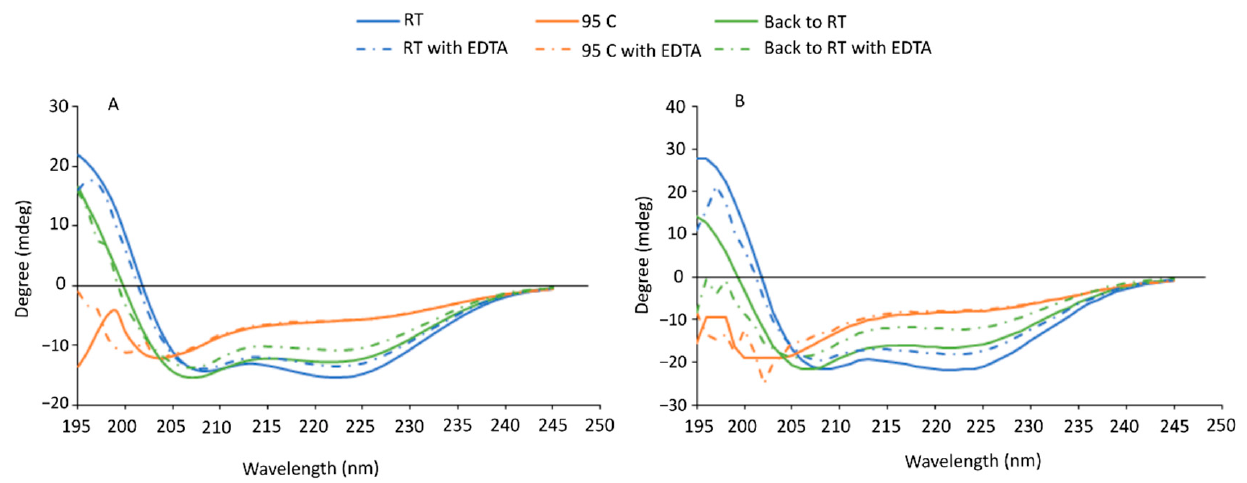
Figure 2. Far-UV circular dichroism analysis of purified β -parvalbumin of ( A ) European seabass and ( B ) gilthead seabream at RT (blue line), 95 ◦ C (orange line) and back to RT (green line). Additionally, purified β -parvalbumin depleted with 5 mM EDTA (dashed lines) is shown for all conditions (RT, 95 ◦ C and back to RT). X -axis represent wavelength (nm) and y -axis the measured ellipticity in degree (mdeg).